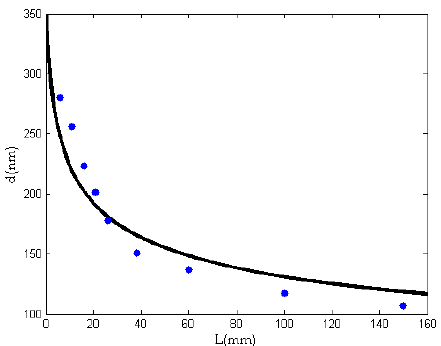
Figure 7. The effect of the needle’s length on the average diameter of nanofibers. Dots: experimental data; Continuous line: theoretical prediction.